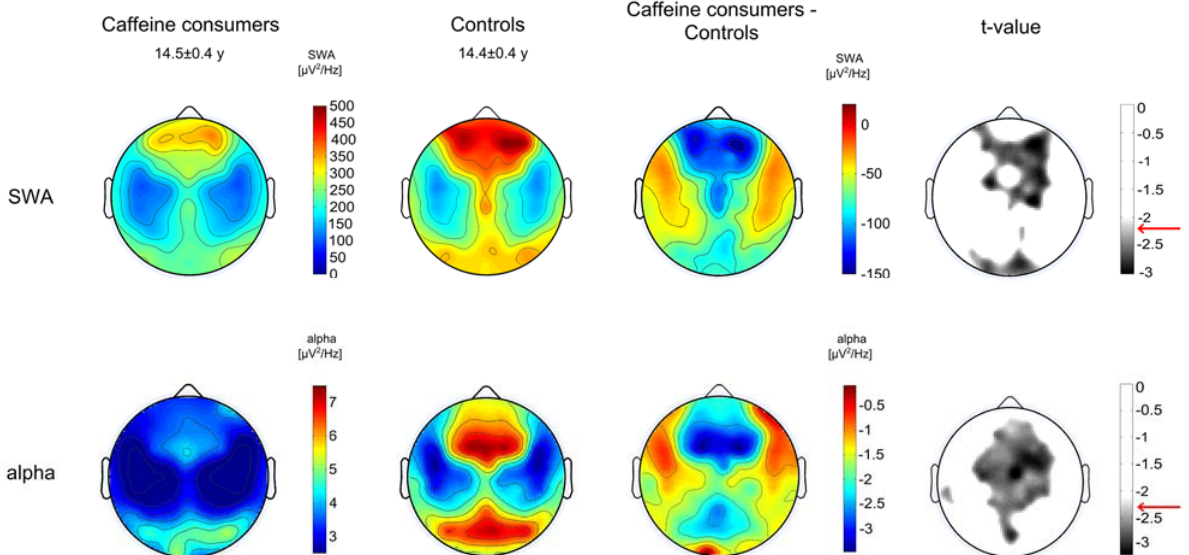
Figure 3. Regional sleep slow-wave activity (SWA, 1–4.5 Hz) and alpha activity (8.25–9.75) in caffeine consumers ( n = 16) and controls ( n = 16). Upper panels show the topographical distribution of SWA averaged for the two groups in NREM stages 2 and 3 during the first two hours of NREM sleep, group differences and the level of significance ( t < − 2.21, two-tailed, unpaired t -test). Lower panels show the topographical distribution of alpha activity averaged for the two groups in NREM stages 2 and 3 during the first two hours of NREM sleep, group differences and the level of significance ( t < − 2.25, two-tailed, unpaired t -test). The significance level is indicated with a red arrow. Values are color coded (maxima in red, minima in blue, respectively maxima in white, minima in black for t -values) and plotted on the planar projection of a hemispheric scalp model. Maps for caffeine consumers and controls are presented using the same color scale, and statistical maps are proportionally scaled to optimize color contrast. Values between electrodes were interpolated in each